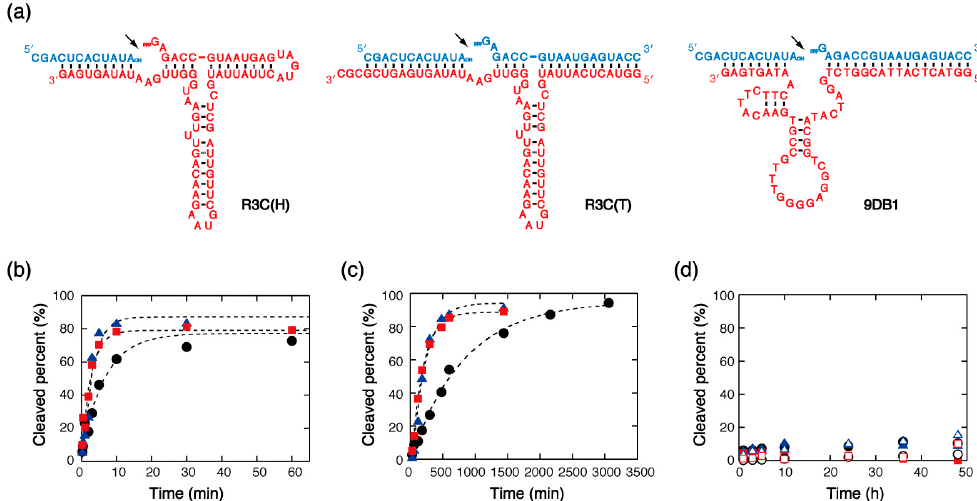
Figure 3. ( a ) Structures of the ligase ribozymes and DNAzyme and their substrates used in this study. The ligation sites are indicated by arrowheads. ( b ) Kinetic traces for substrate ligation catalyzed by R3C(H) under single ‐ turnover conditions in the presence of 10 mM MgCl 2 and in the absence (black circles) and presence of PEG8000 (red squares) or PEG200 (blue triangles). ( c ) Kinetic traces for substrate ligation catalyzed by 9DB1 under single ‐ turnover conditions in the presence of 10 mM MgCl 2 and in the absence (black circles) and presence of PEG8000 (red squares) or PEG200 (blue triangles). ( d ) Kinetic traces for substrate ligation catalyzed by R3C(T) (closed symbols) and 9DB1 (open symbols) under multiple-turnover conditions in the presence of 10 mM MgCl 2 and in the absence (black circles) and presence of PEG8000 (red squares) or PEG200 (blue